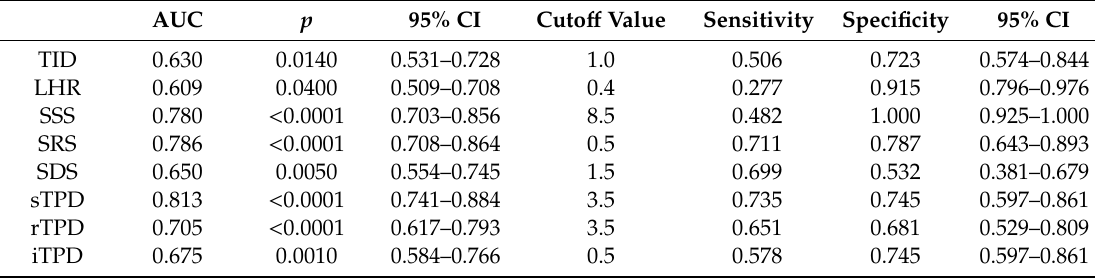
Table 3. Differences in sTPD according to different clinical settings analyzed using Mann–Whitney U tests.